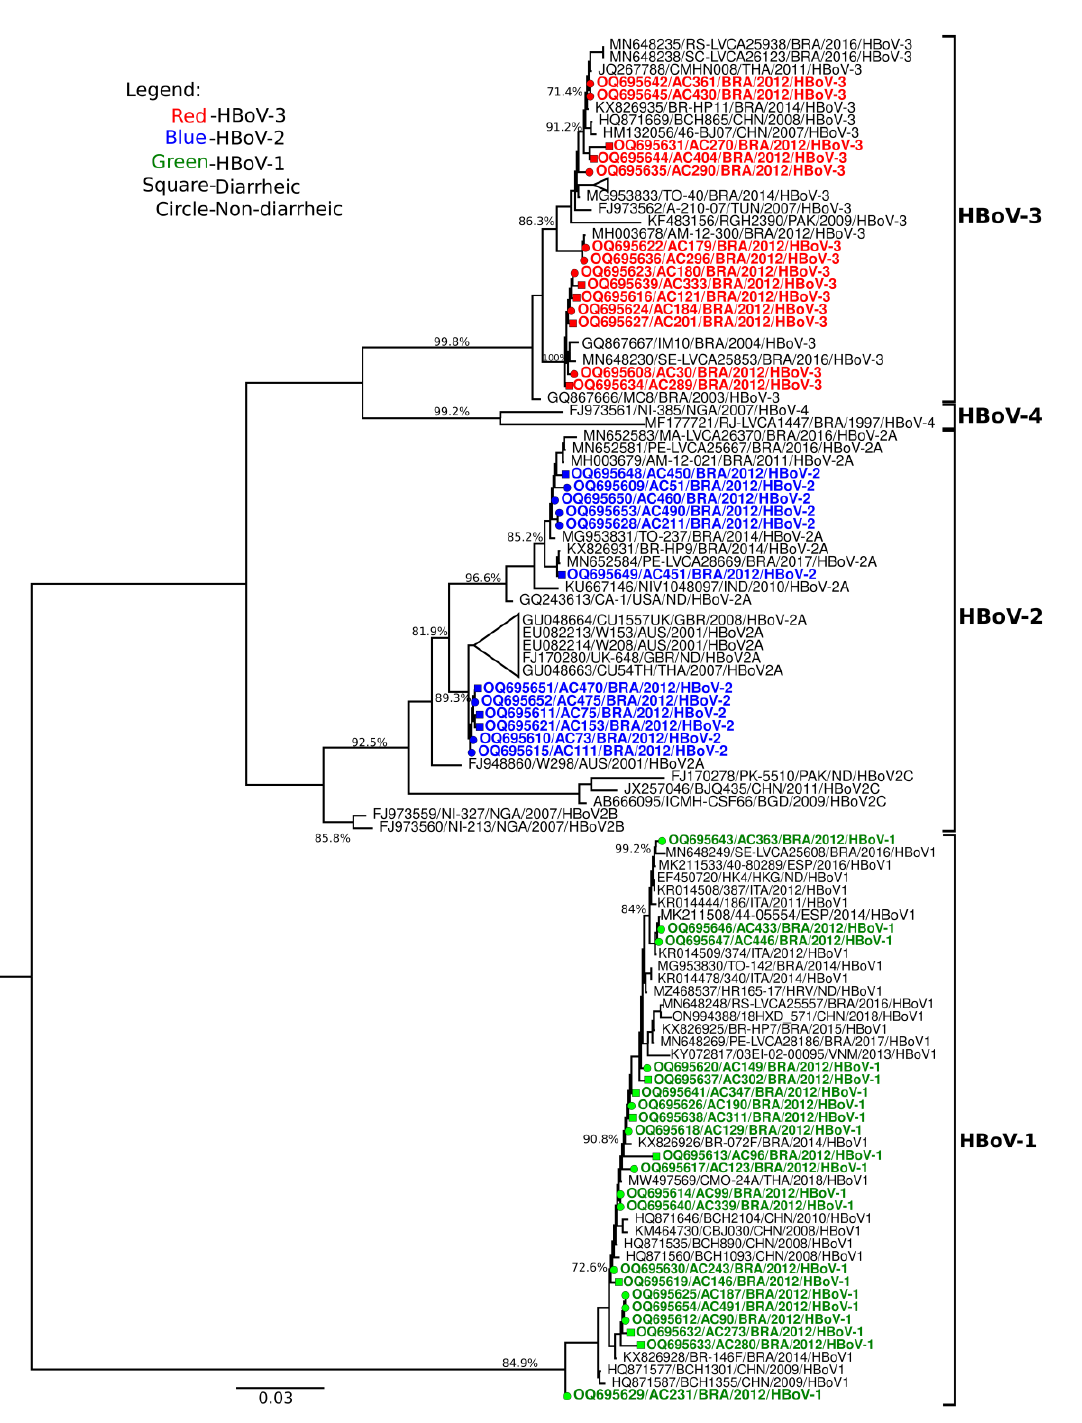
Figure 1. Phylogenetic tree analyses based on the VP1/VP2 gene of HBoV strains in children from Rio Branco, Acre, 2012. GenBank samples were included and accessed according to their reference numbers. The HBoV strains analyzed in this study are shown in bold and are marked in green (HBoV-1), blue (HBoV-2), and red (HBoV-3), with a square (diarrheic) or circle (non-diarrheic). The analysis was inferred using the maximum likelihood method, including the GTR+Gamma+F nucleotide substitution model.